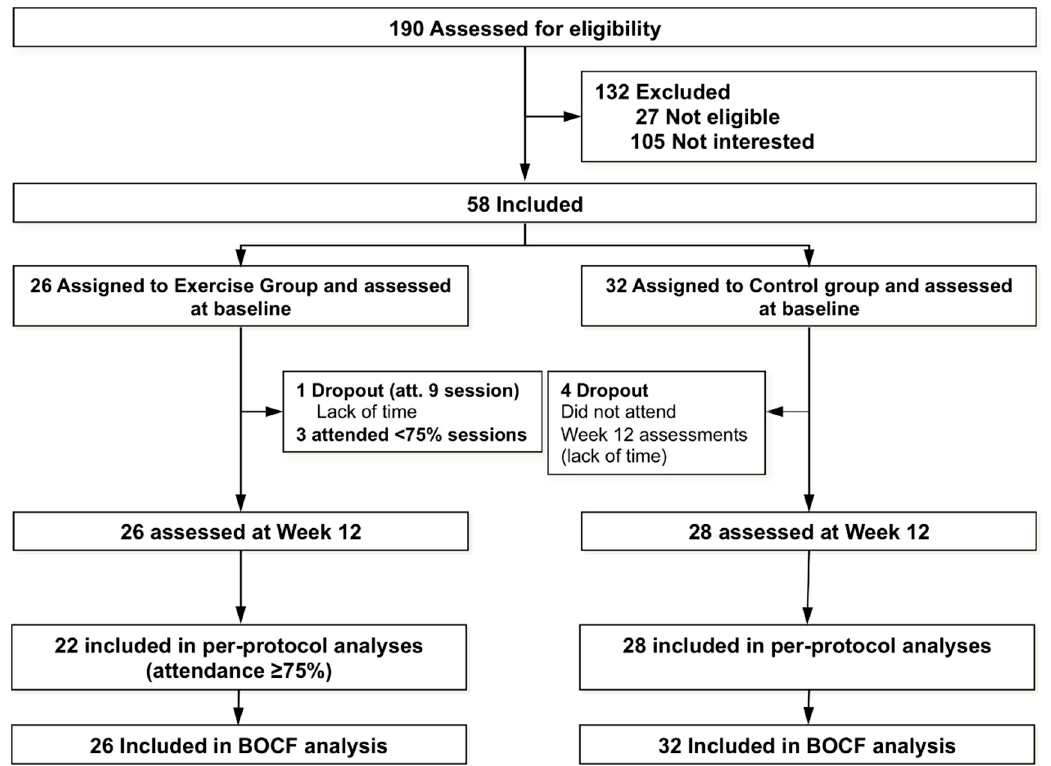
Figure 1. Flow chart of the study participants throughout the